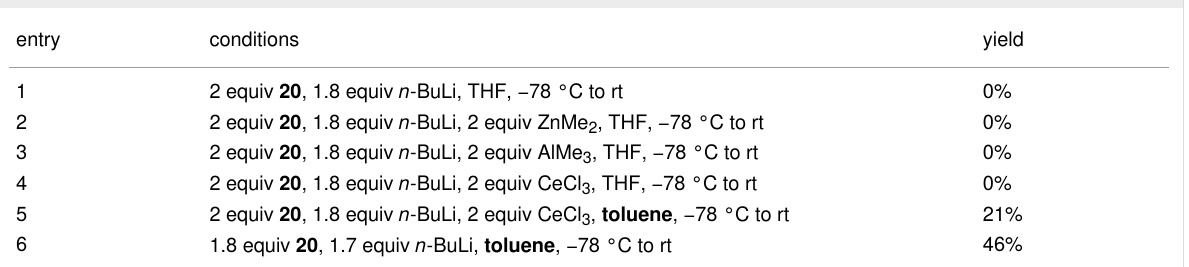
Table 2: Coupling reaction between vinyl iodide 20 and ketone 11b